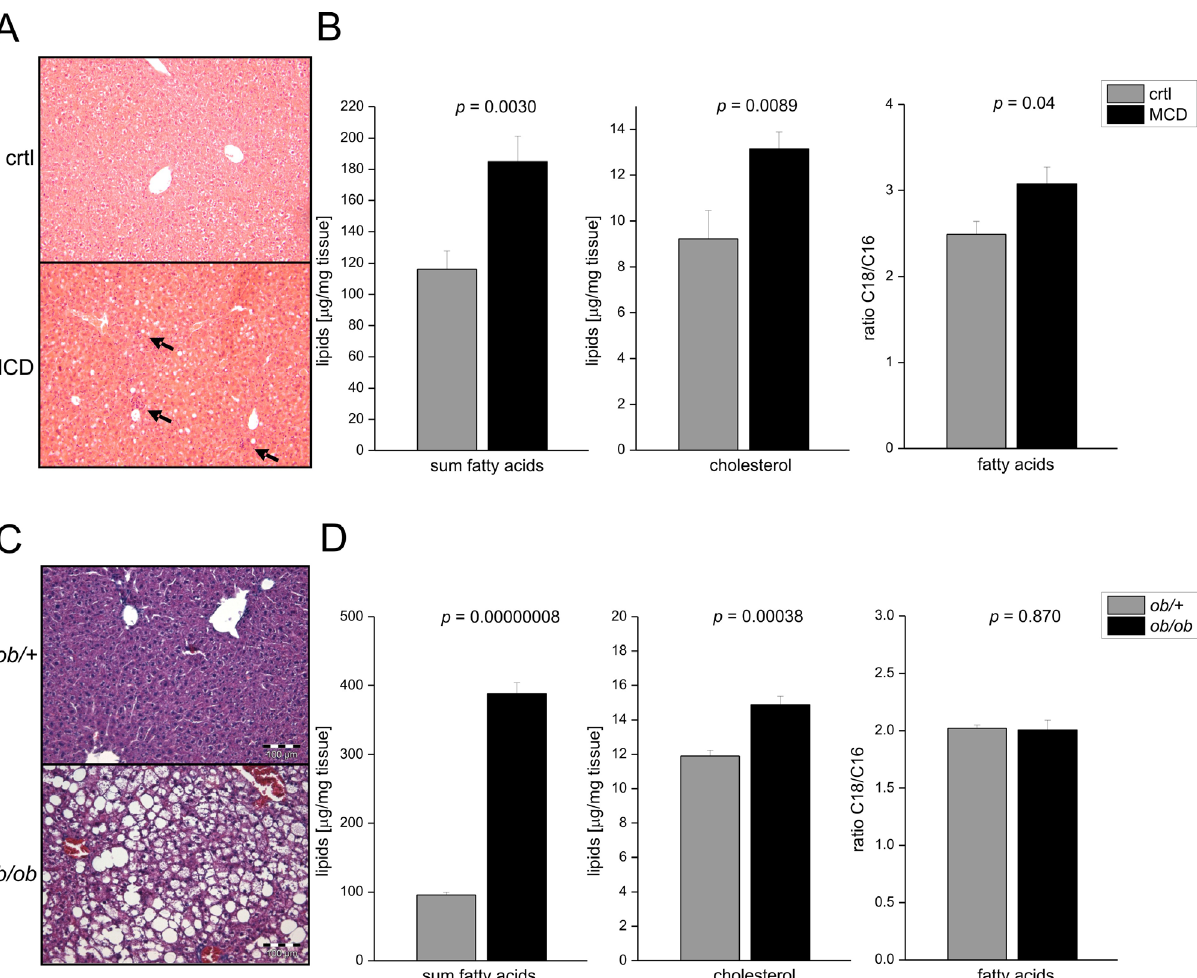
Figure 1. Non-alcoholic steatohepatitis (NASH), but not non-alcoholic fatty liver disease (NAFLD), is accompanied by elevation of C18 over C16. ( A ) Representative liver sections stained with hematoxylin-eosin (HE) from animals fed with either a methionine-choline deficient (MCD) or a control (crtl) diet for 3 weeks (original magnification 200×). Arrows denote inflammatory foci; ( B ) Sum of all hepatic fatty acids, hepatic cholesterol, and ratio of hepatic C18/C16 fatty acids of MCD fed animals compared to ctrl were analyzed by GC-MS (gas chromatography-mass spectrometry) ( n = 9–10); and ( C , D ) Representative HE-stained liver sections ( C ), hepatic fatty acids as well as hepatic cholesterol, and ratio of hepatic C18/C16 fatty acids ( D ) of ob / + and ob / ob mice ( n =